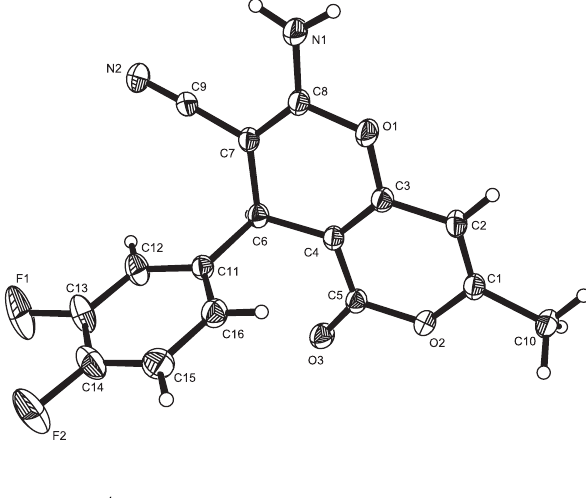
Table 1: Data collection and handling.